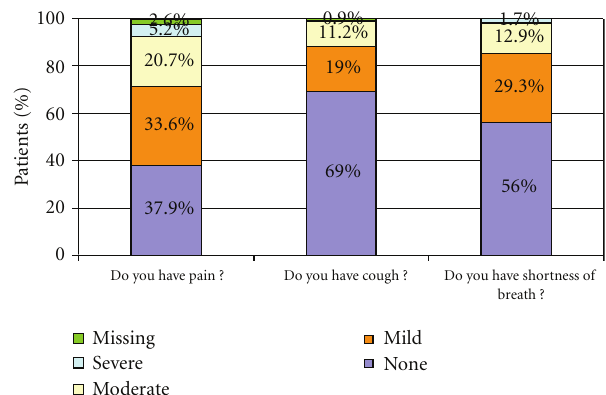
Figure 1: Cancer-related symptoms based on the 3-item question- naire, all